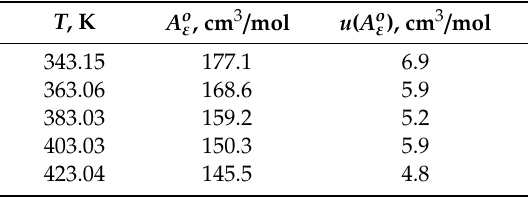
Table 7. Ideal-gas molar polarization data for